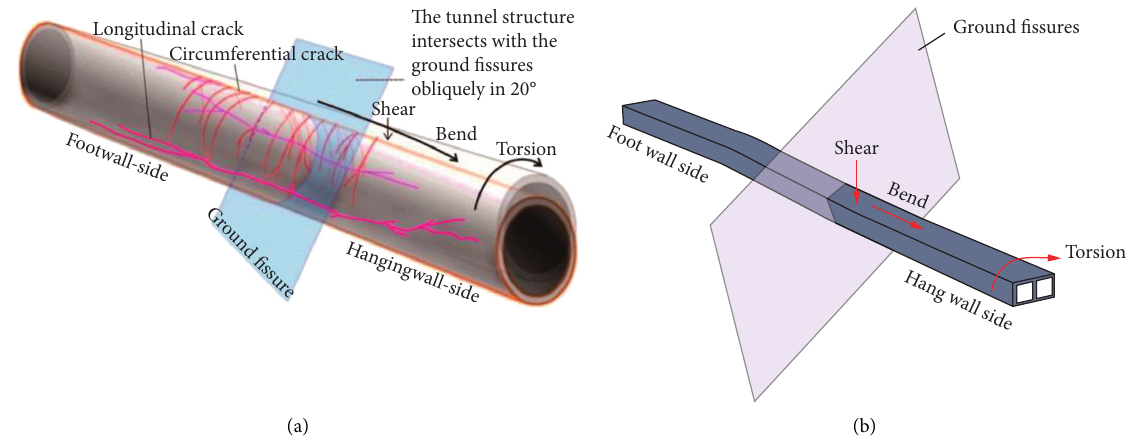
Figure 14: The comparison of general mechanical characteristics between previous research model and simulation model. (a) Previous research model [24]. (b) Simulation model in this paper.